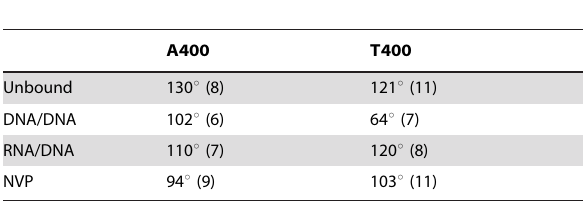
Standard deviations are shown in parentheses.